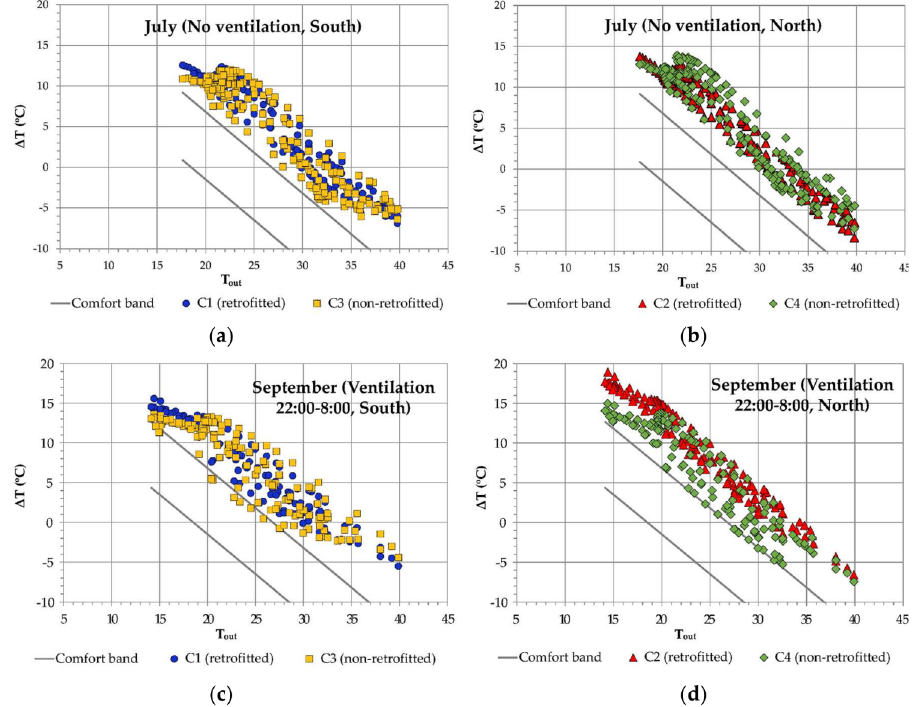
Figure 12. Dispersion diagrams. July protocol: ( a ) south cells; and ( b ) north cells. September protocol: ( c ) south cells; and ( d ) north